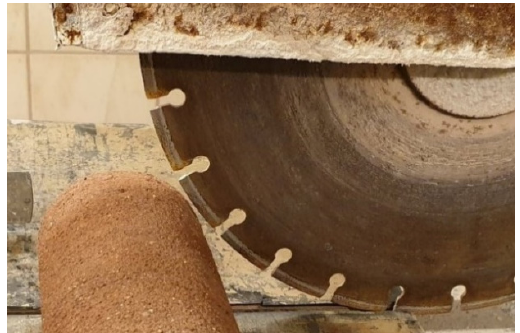
Figure 5. Method of preparing the discs from the cylinder.